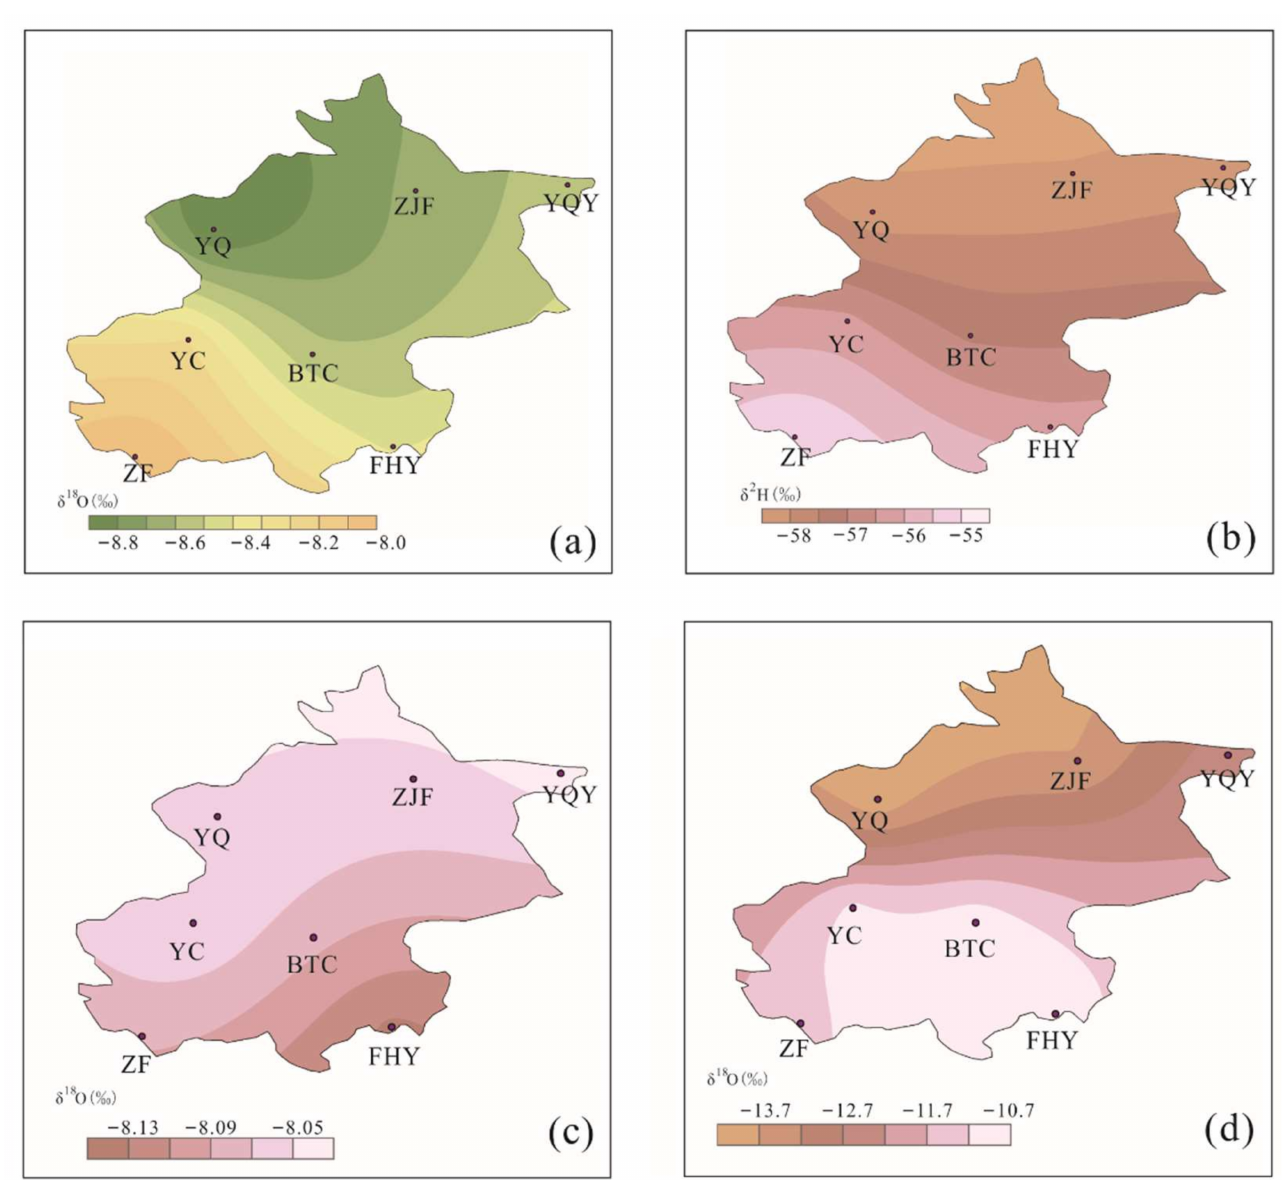
Figure 2. Mean annual gridded values of stable isotopes compositions of meteoric waters over